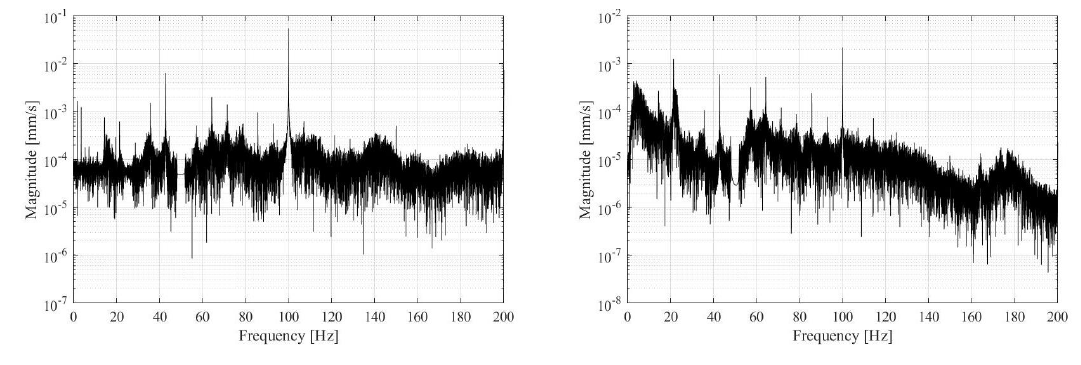
Figure 8. Frequency spectrum of the uncorrected vibrometer signal ( a ) and the correction signal from accelerometers 2 and 3 ( b ).